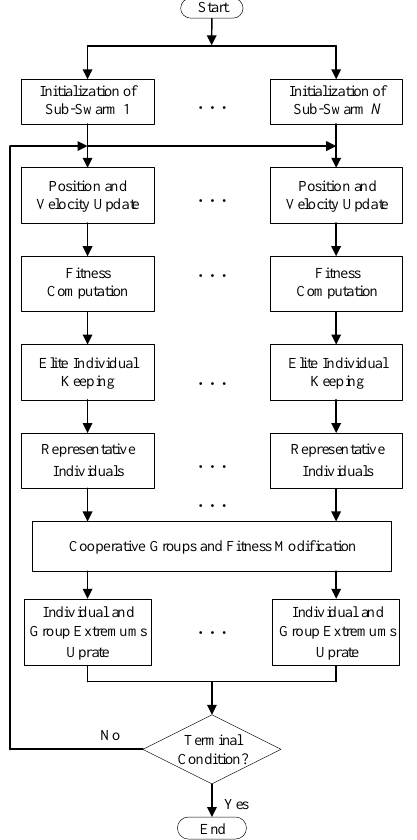
Figure 2. Flow chart of distributed cooperative particle swarm optimization (DCPSO) with